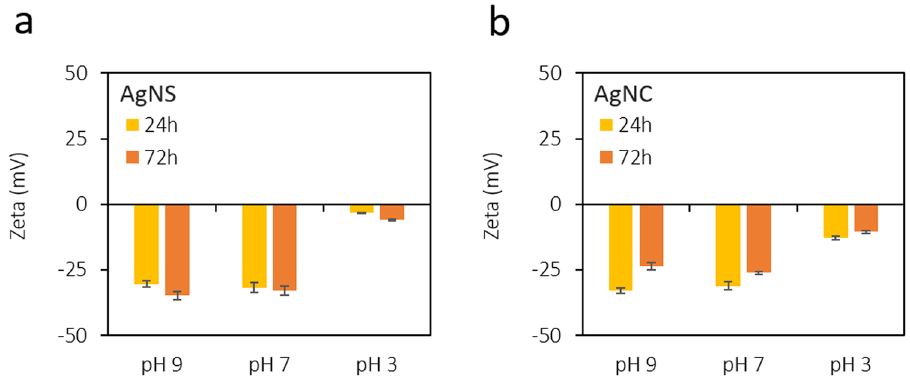
Figure 3. Changes in surface charge (zeta potential) for nanoparticles in different pH conditions: ( a ) AgNS and ( b ) AgNC.